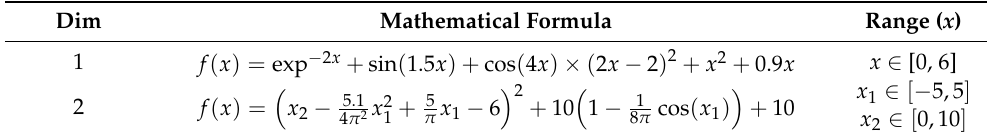
Table 1. Information and characteristics of the benchmarks.